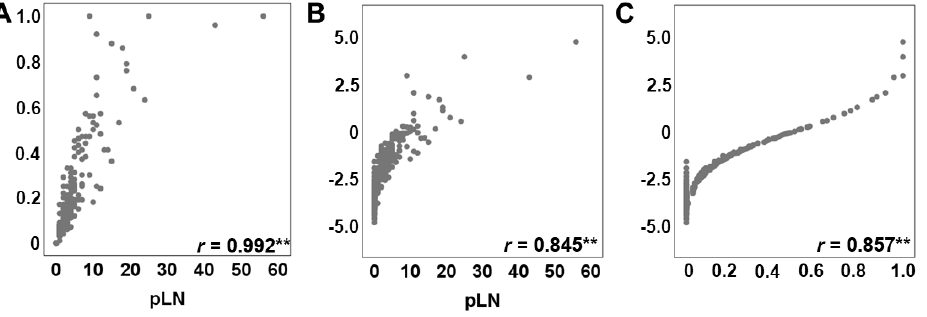
Figure 2. Relationship between positive lymph nodes (pLN), LNR and LODDS. Scatter plots presenting the distribution of ( A ) LNR versus pLN, ( B ) LODDS versus pLN and ( C ) LNR versus LODDS. ** p < 0.001. Table 2. Cox regression analysis of the variables considered for the multi-variable adjusted base